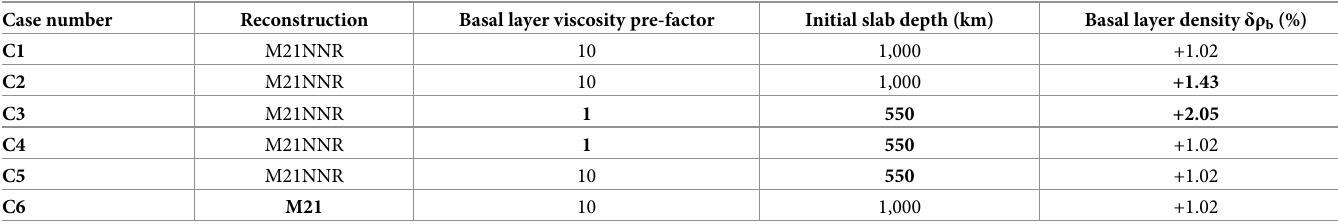
Table 1. Parameters varied across mantle flow models.